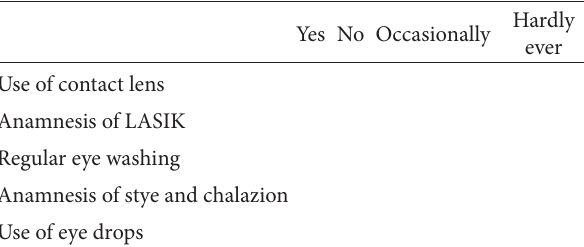
Table 3: Questionnaire of eye care habits.